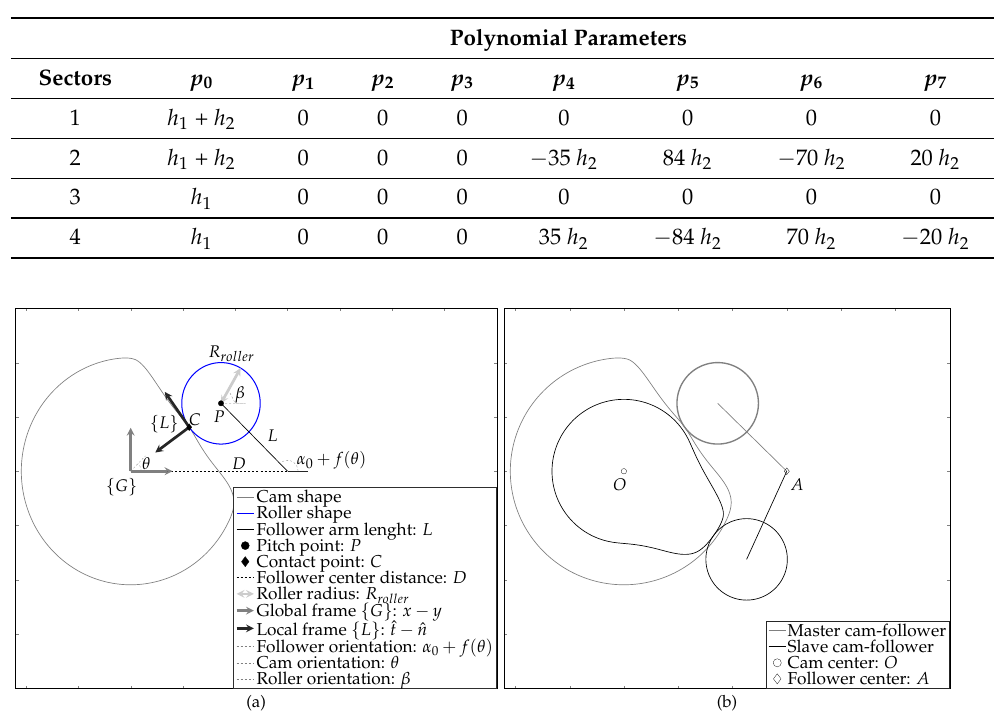
Table 1. Seventh-order polynomial parameter values.